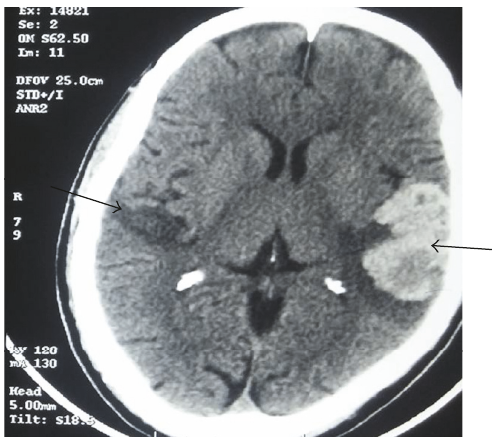
Figure 1: CT head showing infarcts in bilateral temporal lobes with haemorrhagic transformation on left.